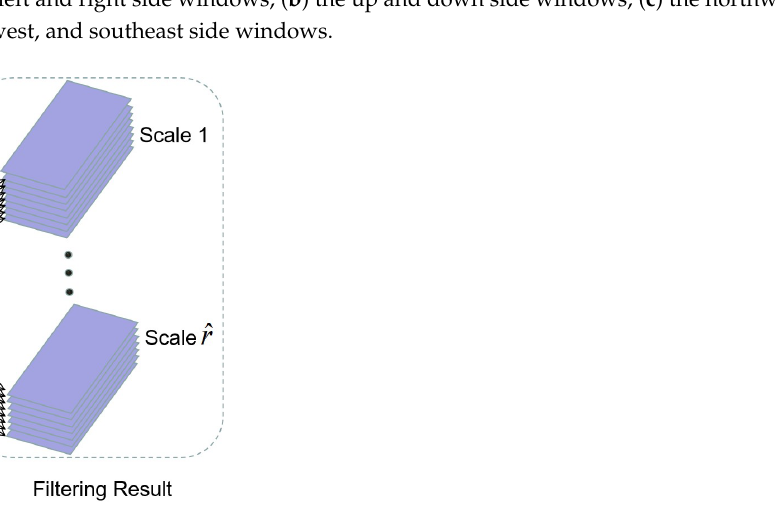
Figure 4. Multiscale filtering on band i , where 8 × ˆ r feature maps have been derived from one band. Note that the side window technique can be embedded into a wide variety of filters, such as Gaussian filter, median filter, bilateral filter, and guided filter. In this paper, box filter is used for simplicity. Then, the output is given by